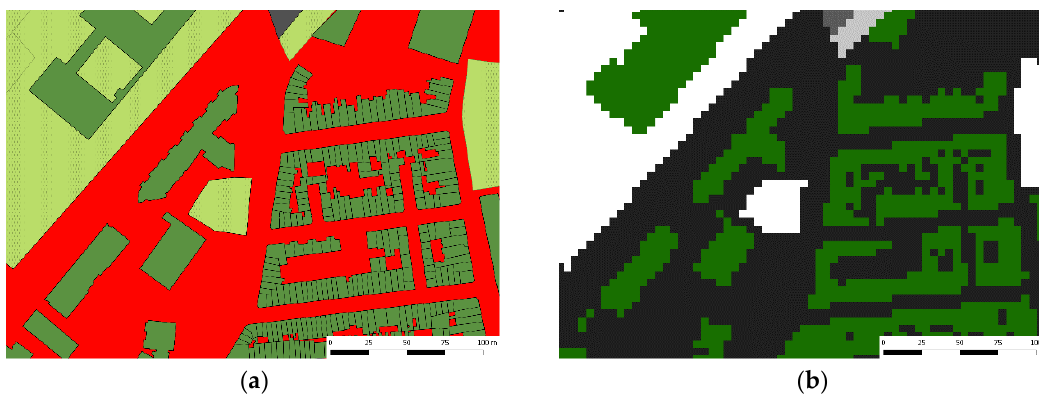
Figure 3. There is a loss of information when vector data ( a ) is converted to raster data ( b ), which includes the loss of features’ shape, structure, position, attribute and so on.